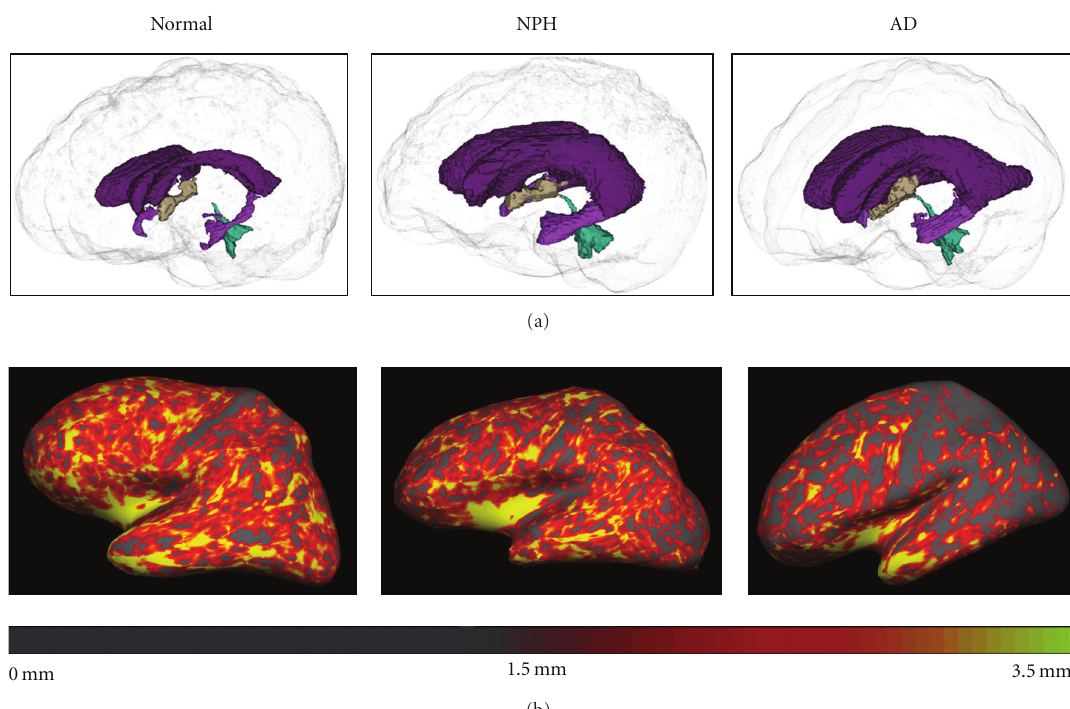
Figure 1: (a) Three-dimensional representation of the ventricles in normal, NPH, and AD participant (left to right). The ventricles of the NPH and the AD participants are enlarged relative to the normal participant. (b) FreeSurfer’s cortical thickness maps in the same normal, NPH, and AD participant (left to right) are shown. The cortex of the AD participant is notably thinner, particularly in posterior regions, than that of the normal and NPH